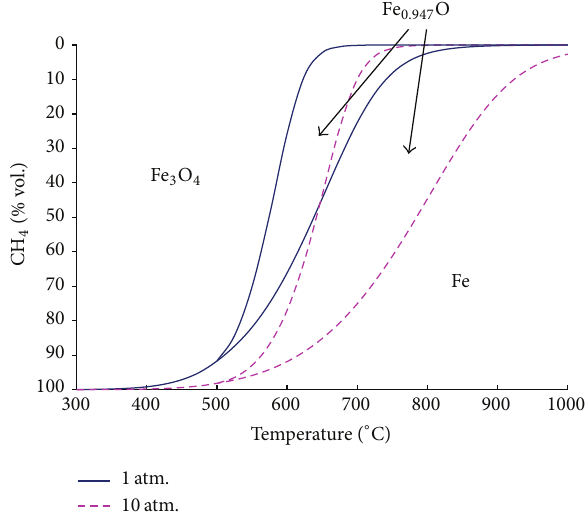
Figure 4: The phase stability diagram of Fe, Fe 0.947 O, and Fe 3 O 4 phases in the CH 4 -CO 2 -H 2 O